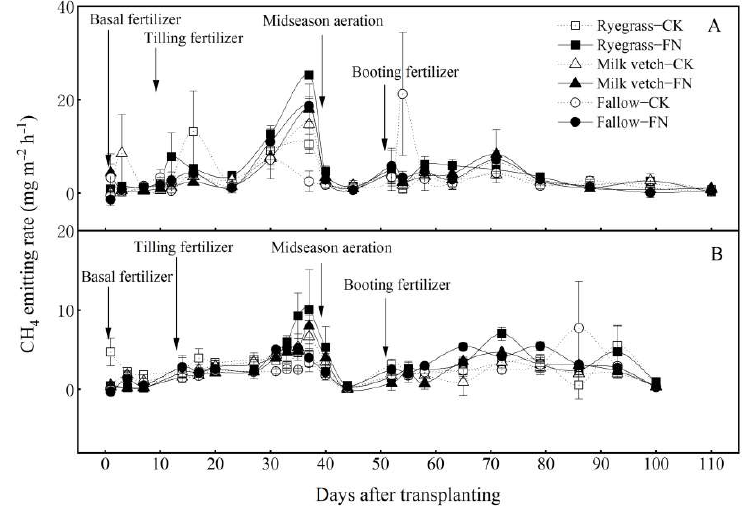
Figure 3. CH 4 emitting dynamics (means ± se) under green manure amendment with/without fertilization for the two sampling seasons (( A ), 2019; ( B ), 2020). Table 4. Grain yields and CH 4 emissions under fertilization and green manure